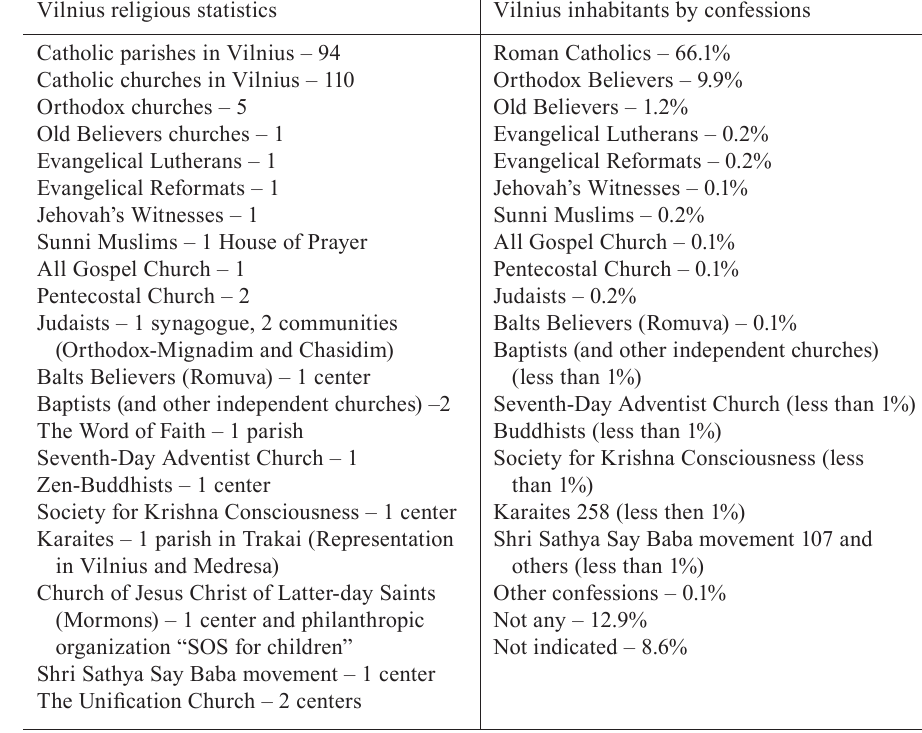
Table 1. Statistic supplement